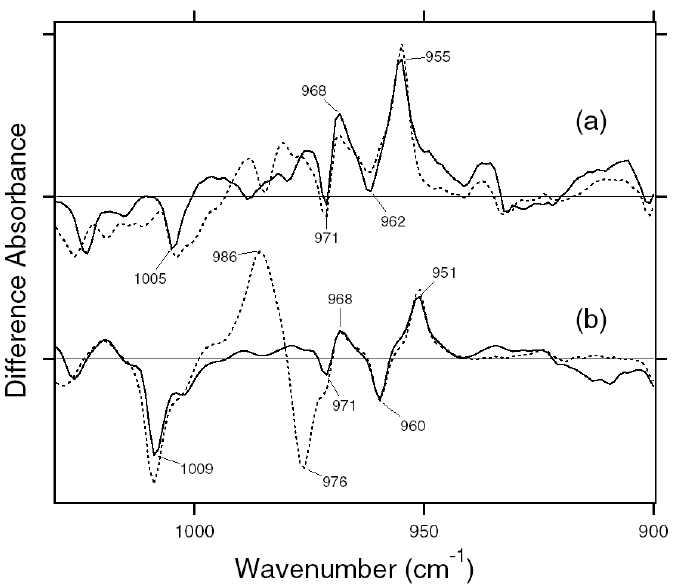
Figure 34. The ASR minus ASR (a) and the BR minus BR (b) spectra in L L the 1,030–900 cm -1 region, which correspond to hydrogen-out-of-plane (HOOP) vibrations of the retinal chromophore. The sample was hydrated with H O (solid lines) or D O (dotted 2 2 lines). One division of the y-axis corresponds to 0.0016 absorbance units. This figure is reprinted with permission from Kawanabe et al [77]. Copyright 2008 American Chemical